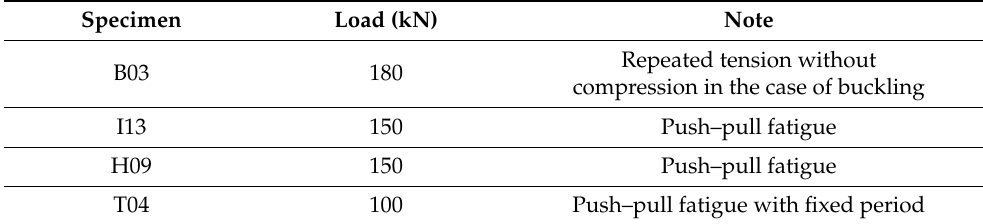
Table 4. Load specifications of the specimens.